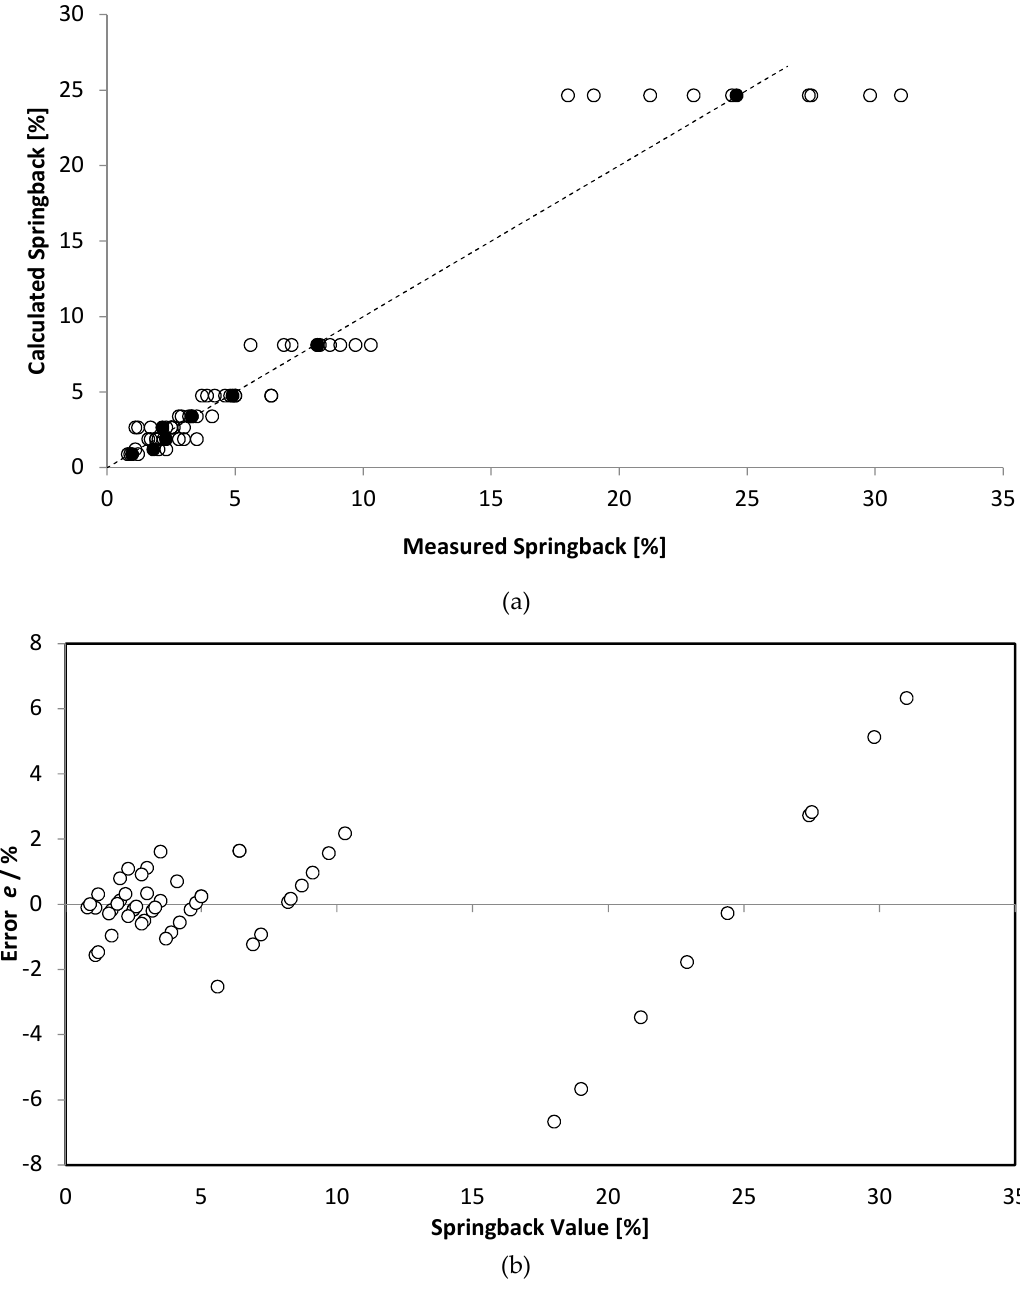
Figure 5. ( a ) Parity plot of all 57 springback values (circle) and mean values (black dot) obtained by measurement and calculation with the formula (12). ( b ) Error plot of all 57 springback values (circle) obtained by measurement and calculation with the formula (12).